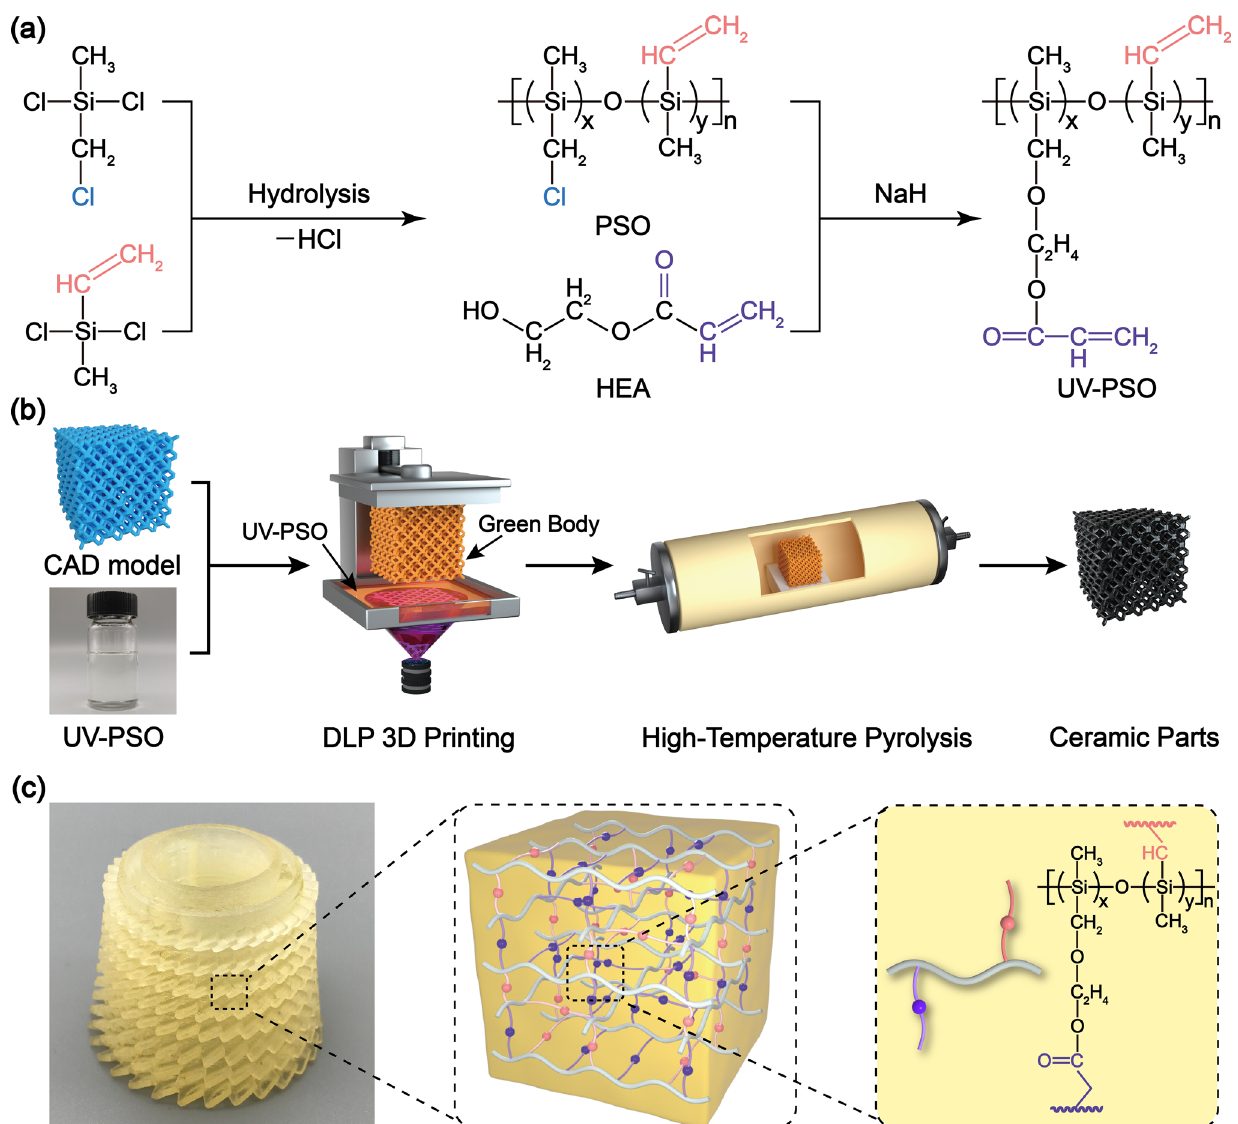
Fig. 1 Synthesis route of the UV-curable polysiloxane and schematic DLP printing process and preparation of the designed Si–O–C ceramic metamaterial: a synthesis route of UV–PSO; b 3D printing of UV–PSO and pyrolysis process of Si–O–C ceramic metamaterial; and c photo- graph of a representative booster blade DLP-printed green body and two kinds cross-linked molecular structure of the